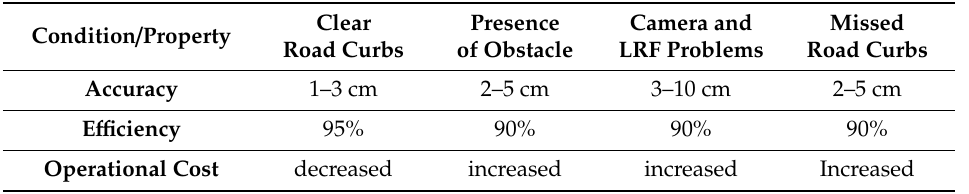
Table 1. An average accuracy, e ffi ciency, and operational cost for road following with 5 m as width and 500 m as